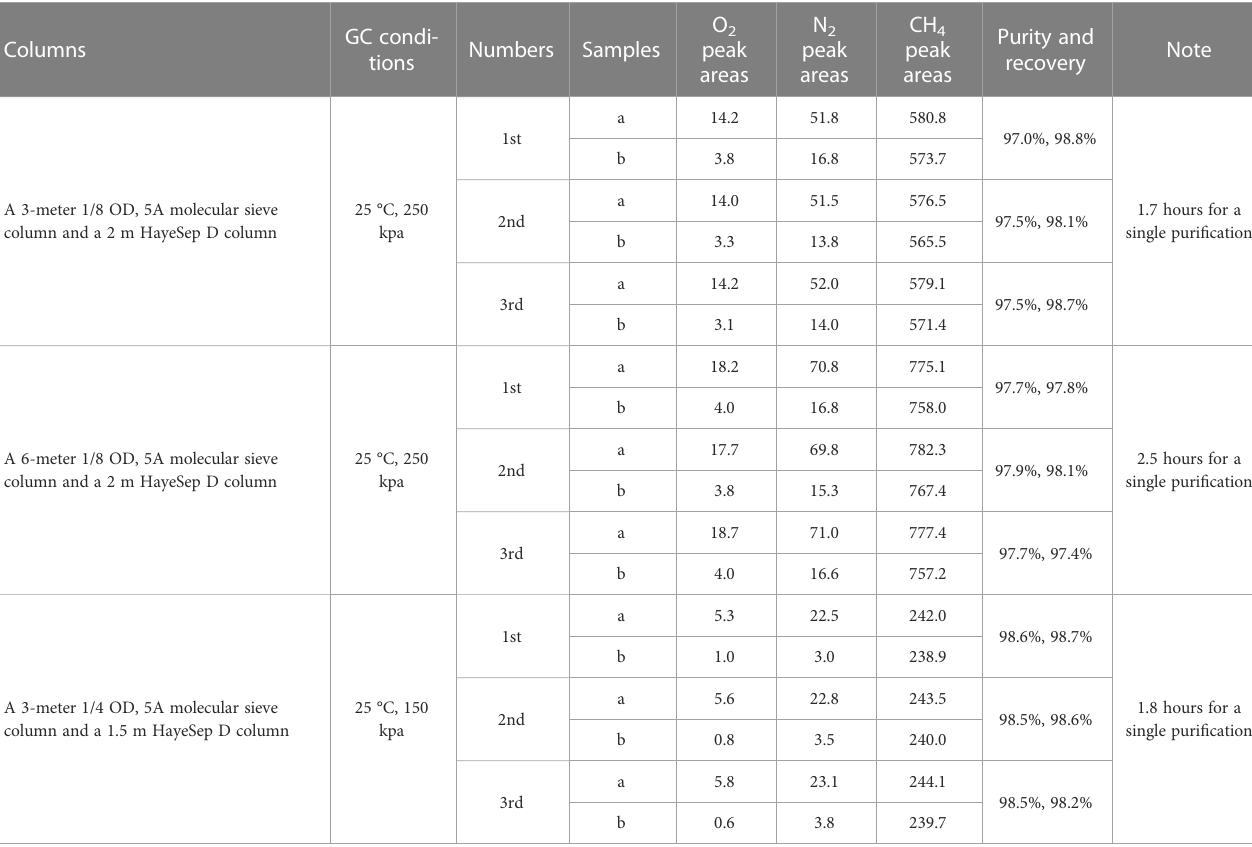
TABLE 3 Comparison of puri fi cation results with different GC columns.